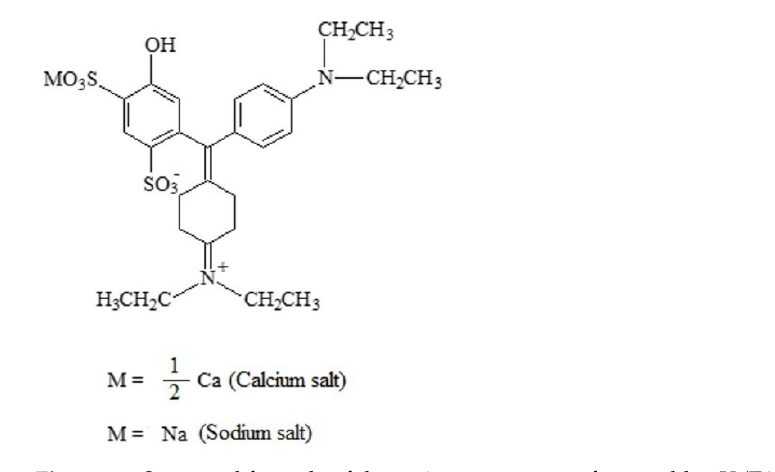
24 of 34 Figure 22. Structural formula of allura red AC (E129). This additive is used in decorations and coatings for pastry products, confectionery including breath refreshing and chewing gum, pastry and fine bakery products, flavoured fermented milk products, edible cheese rinds, desserts, preserves of fruits, ice cream, fla- voured drinks, baked crustaceans, seafood, breakfast sausages, appetizers, sauces, season- ings, soups, luncheon meat, replacements, and alcoholic beverages [3]. An acceptable daily intake of 7 mg/kg bw has been indicated [119]. Regarding possible side effects on health, it has been reported that E129 is an allergizing substance which worsens or induces asthma, rhinitis, or hives [18]. There is also the possibility of the pres- ence of carcinogenic residues in this food colouring, and it is suspected of hyperkinesia [16]. McCann et al. [14] further concluded that exposure to a mixture of artificial food colourings, including allura red AC, resulted in increased hyperactivity in 8–9-year old children. 2.2.9. Patent Blue V